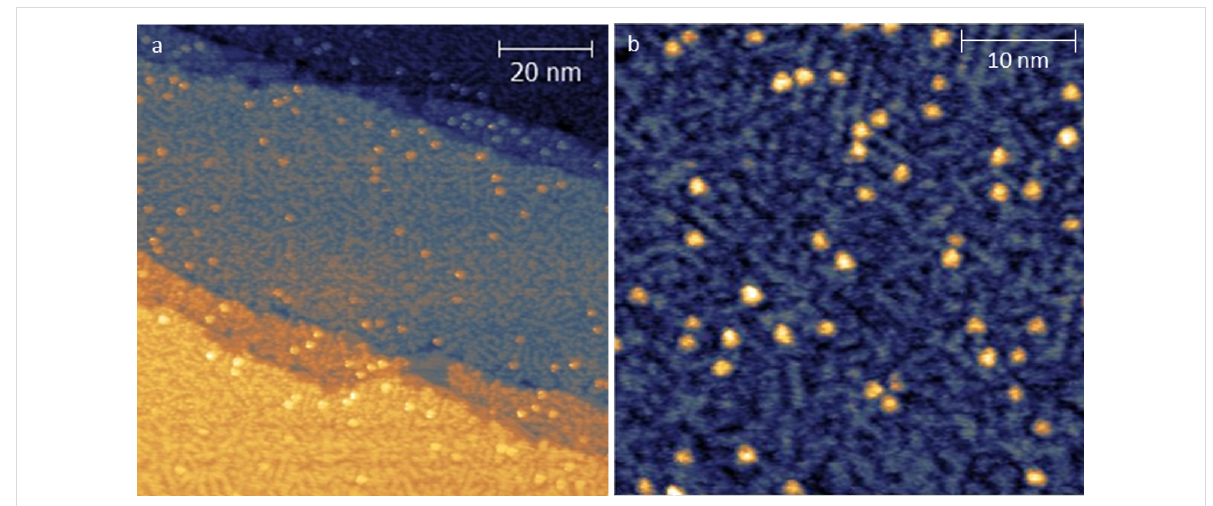
Figure 6: STM images for saturation coverage of Fe(dpm) 3 on Au(111) at T = 30 K. (a) t 6 = 10 min (HR); size = 100 × 100 nm 2 , bias = 1.5 V (filled states), I = 10 pA. (b) t 7 = 1 min (HR); size = 45 × 45 nm 2 , bias = 1.5 V (filled states), I = 10 pA.